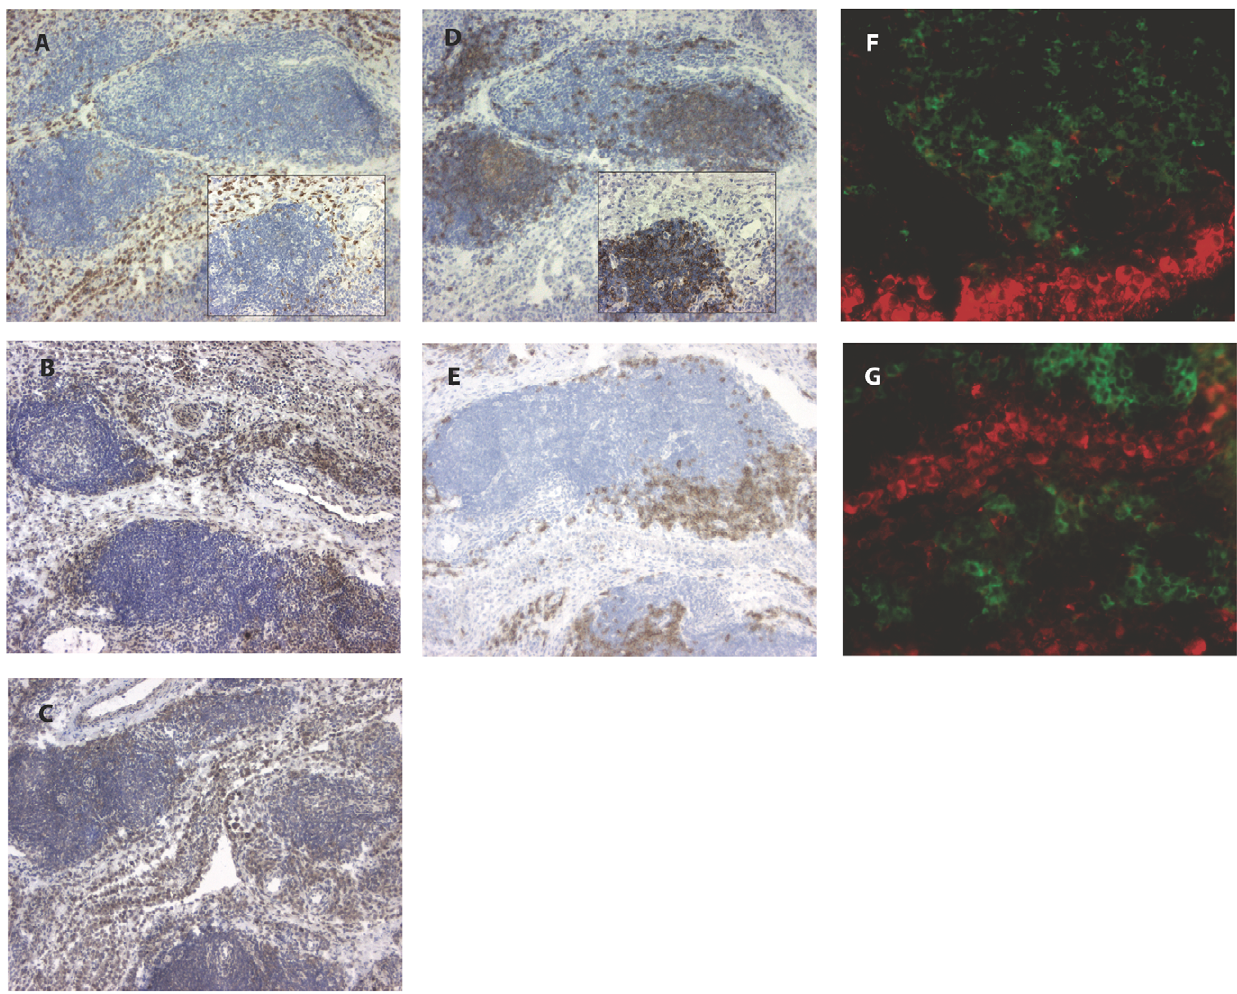
Figure 2. MPGES1 is not expressed in B cell-rich areas in RA synovium. Frozen sections of synovial tissue showing diaminobenzidine (brown) staining of MPGES1 (A), COX-2 (B), COX-1 (C) and CD20 B cells (D), CD138 plasma cells (E) (hematoxiline counterstained). Insets represent higher power of image A and D. Original magnification 80x and 200x (insets). (F) and (G) Immunofluorescence pictures of double stained MPGES1 (red) and CD20 + B cells (F) and CD138 + plasma cells (G) (green). Magnification 400x.